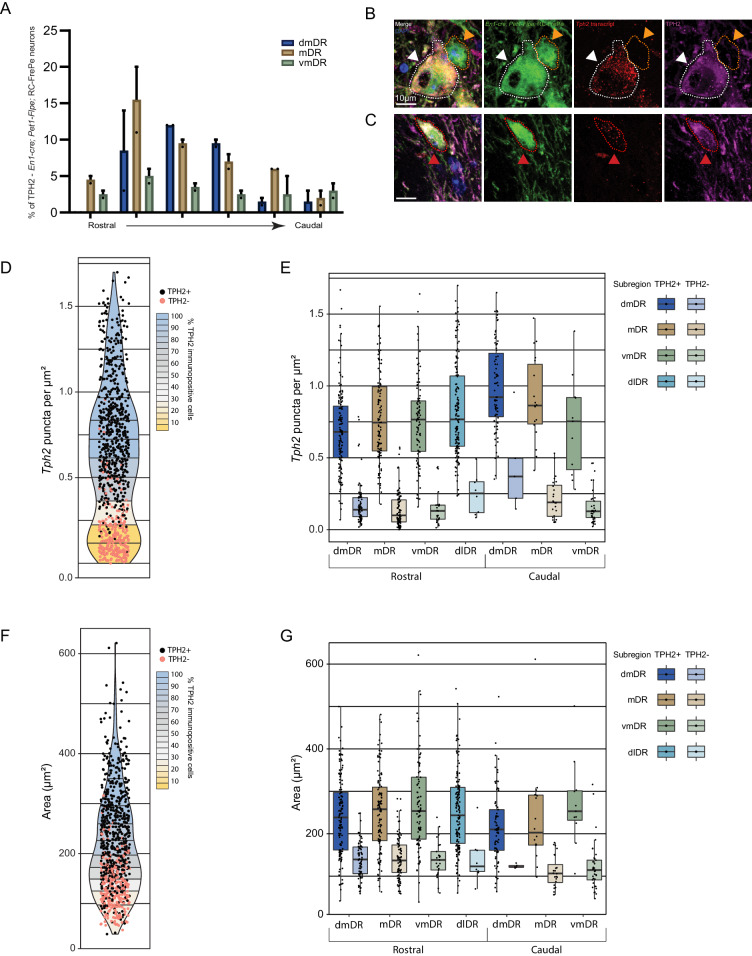
Diversity of Tph2 RNA transcripts and protein expression in dorsal raphe Pet1 neurons.(A) Bar graph showing the percentage of the total population of EGFP-positive TPH2-negative cells counted in a specific anatomical subdivision of the DR in En1-cre; Pet1-Flpe; RC-FrePe animals (Green labeled neurons with intersectional expression of En1-cre and Pet1-Flpe). n = 2, bar graph depicting the mean with SEM. (B, C) Images showing co-visualization of EGFP (green) and TPH2 (magenta) by immunofluorescence and Tph2 transcripts (red) by RNAscope in En1-cre; Pet1-Flpe; RC-FrePe neurons. Examples for a TPH2 immunopositive cell with high Tph2 transcripts (white arrow in B), a TPH2 immunonegative cell with low Tph2 transcripts (orange arrow in B), and a TPH2 immunopositive cell with medium levels of Tph2 transcript (red arrow in C) are shown. Scale bars are 10 µm. (D) Violin plot depicting the number of Tph2 puncta per um2 of each counted EGFP+ cell (from an En1-cre; Pet1-Flpe; RC-FrePe animal) that was TPH2 immunopositive (black) or TPH2 immunonegative (pink). The violin plot is split into deciles, with fill color representing the percent of TPH2 immunopositive cells within a given decile. (E) Box plots depicting the number of Tph2 puncta for each counted EGFP+ cell that was TPH2 immunopositive (darker shade, left) or TPH2 immunonegative (lighter shade, right), split across DR subanatomy (Rostral and Caudal, dorsomedial DR (blue), medial DR (tan), ventromedial DR (green), dorsolateral DR (turquoise)). (F) and (G) same as D and E, except depicting cell area.